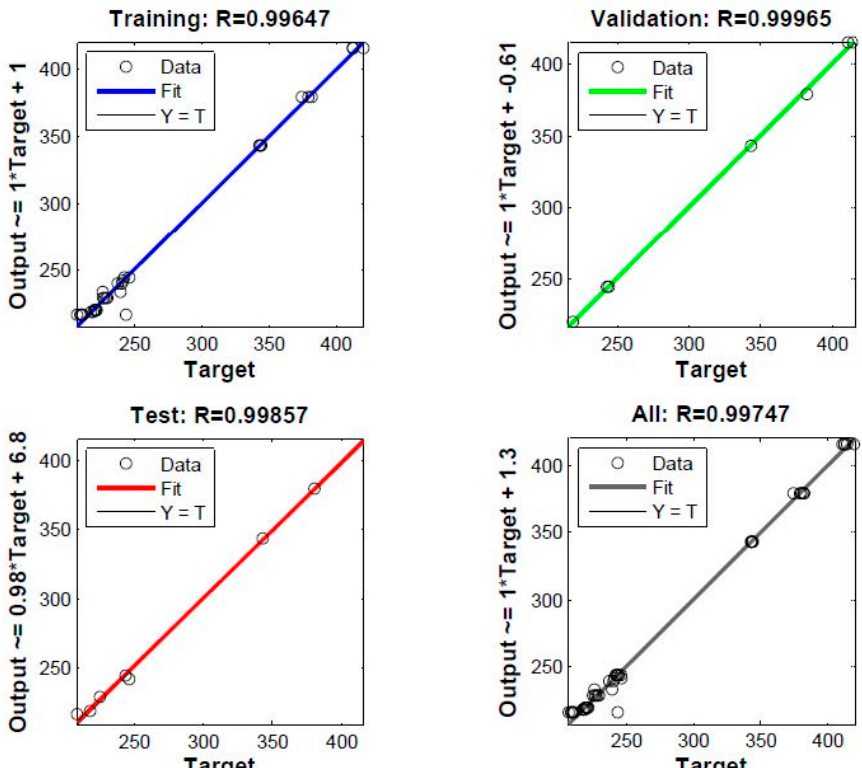
Figure 5. Prediction of modulus by DNN model: regression plot.